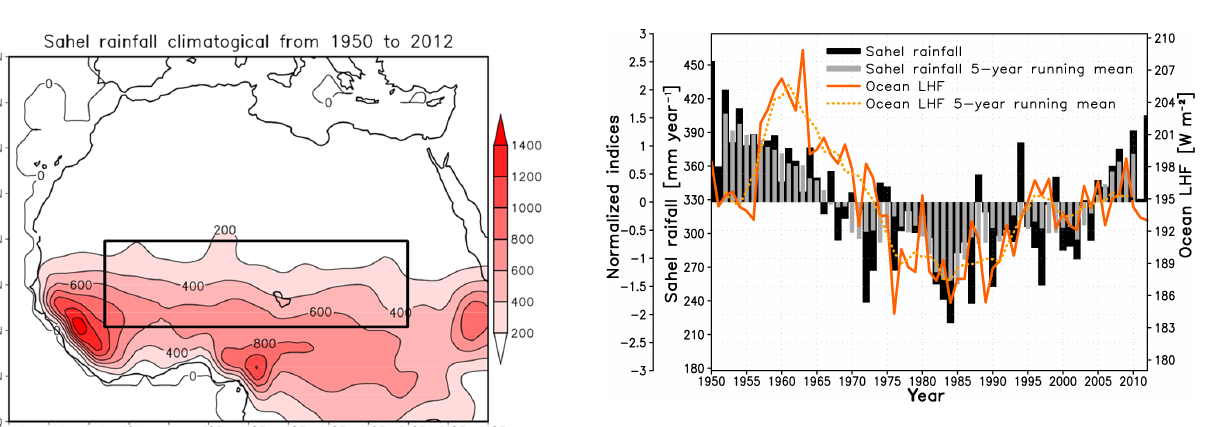
Figure 2. Time series of JAS Sahel rainfall (mm) and mean LHF (Wm − 2 ) from oceans from 1950 to